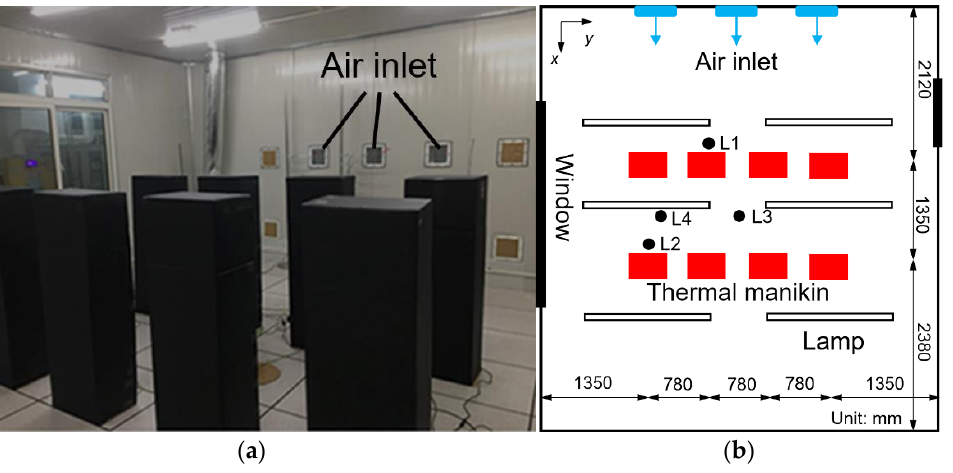
Figure 1. Experimental platform: ( a ) laboratory layout; ( b ) layout plan of sampling lines.